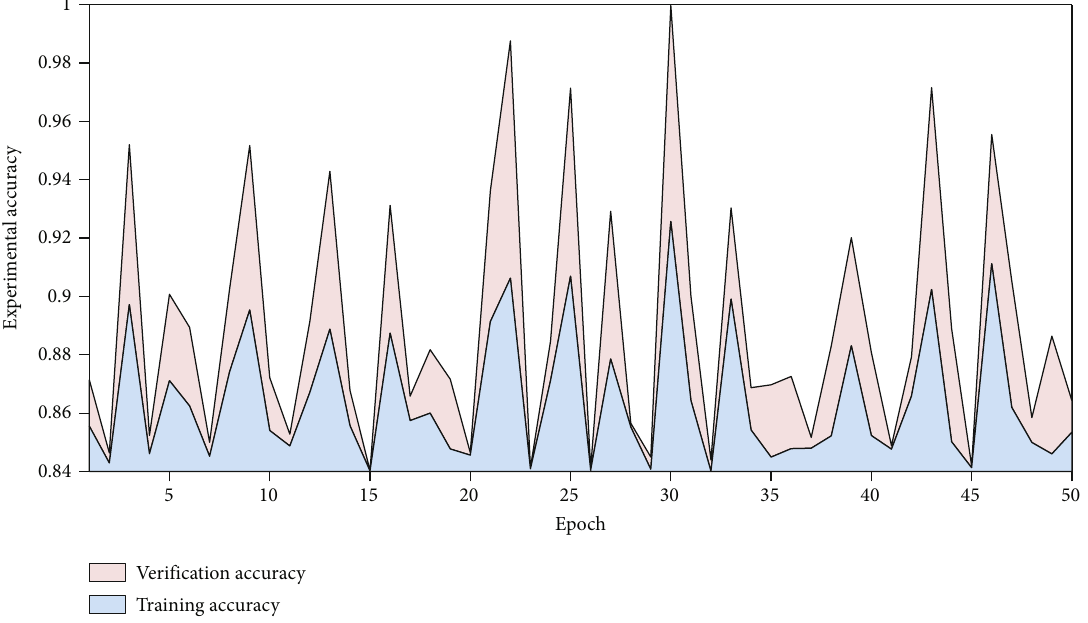
Figure 6: Accuracy map of partial di ff erential equation neural network based on mean curvature